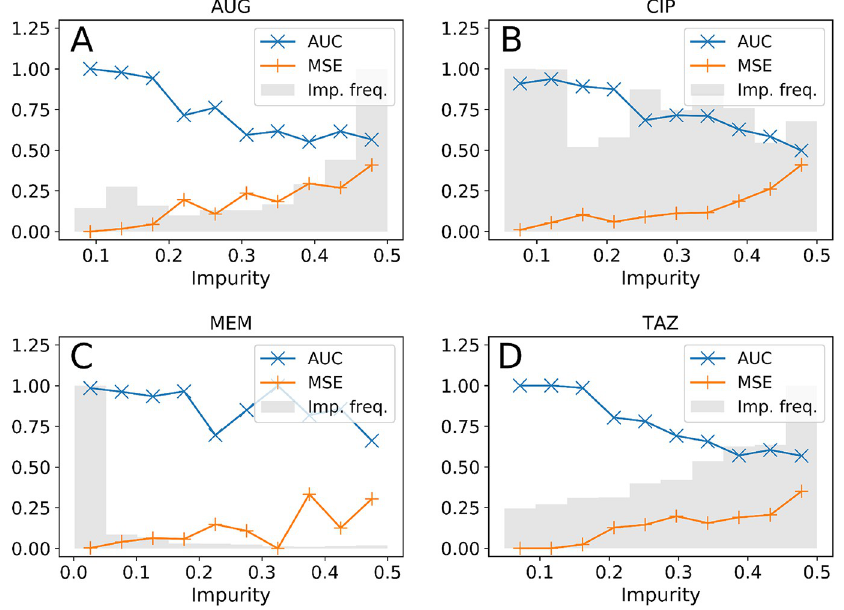
Fig 1. Prediction accuracy vs prediction impurity. Impurity frequency not to scale.